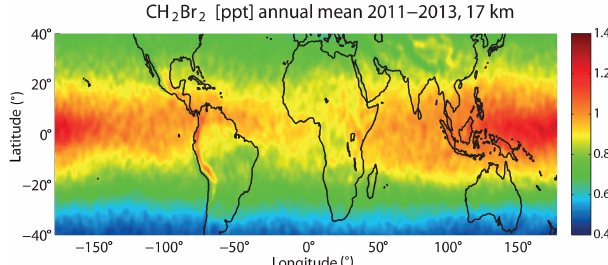
Figure 11. Modelled tropical annual mean distribution of CH 2 Br 2 (ppt) at 17km for 2011–2013.